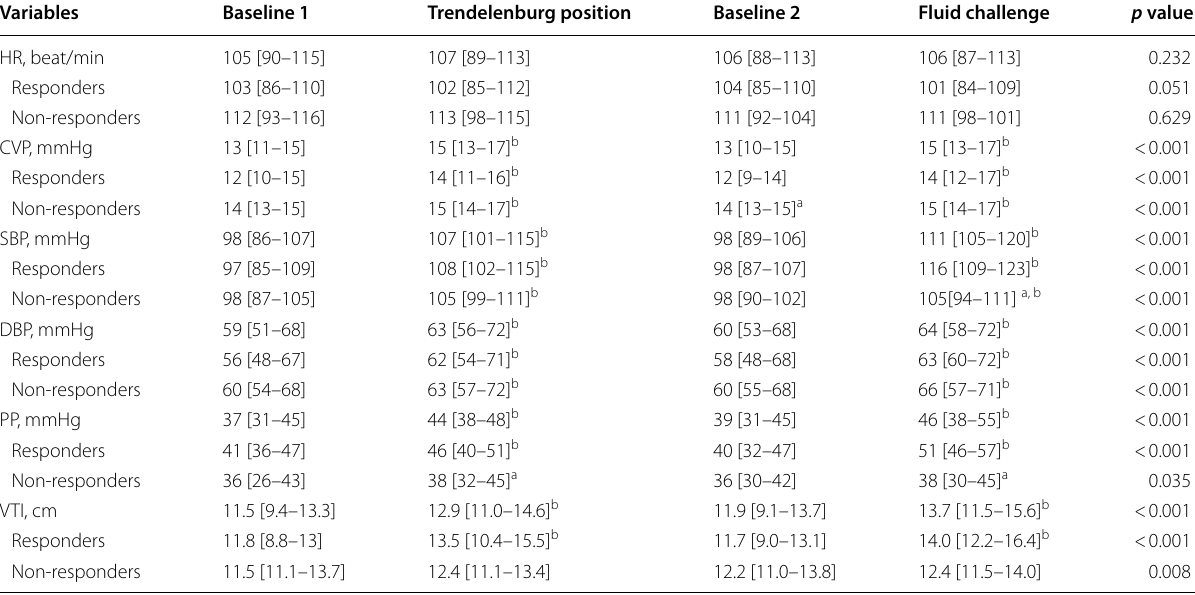
Table 3 Hemodynamic parameters at baselines, at the Trendelenburg position and after fluid challenge in responders ( n 22) and non-responders ( n =